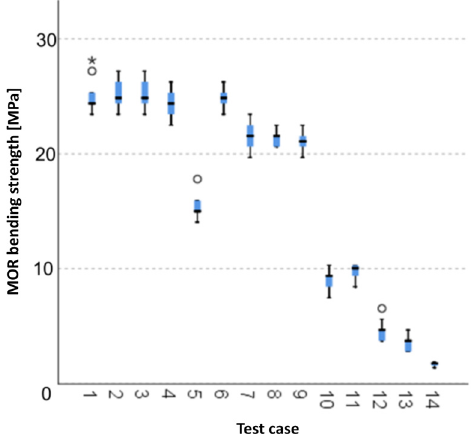
Figure 15. Graphic presentation of the Kruskal–Wallis test results for independent samples: MOR bending strength.